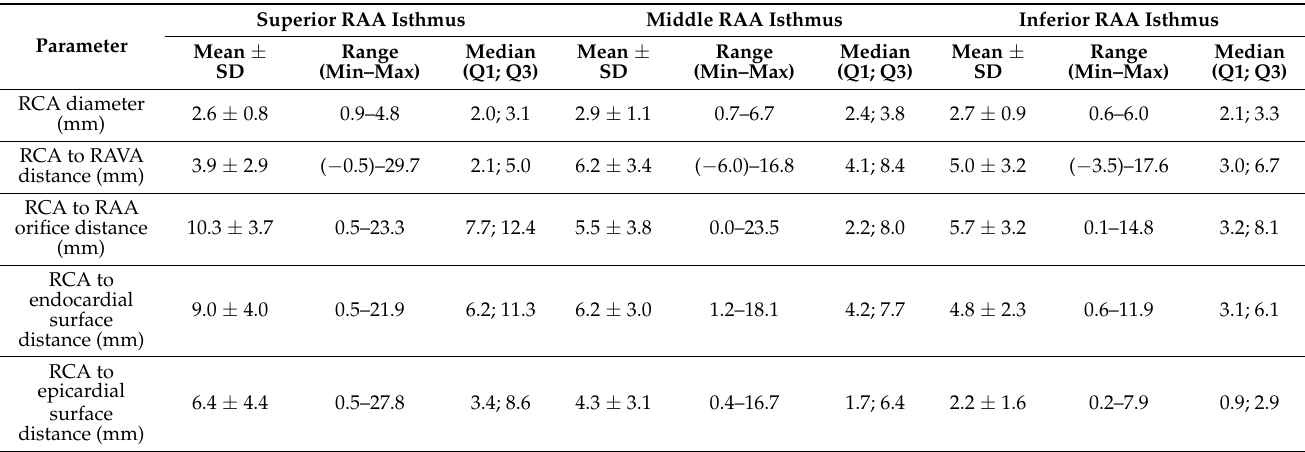
Table 1. Dimensions of the right coronary artery (RCA) identified within the right atrial appendage (RAA) isthmuses and its relations to the endocardial surface, right atrioventricular valve annulus (RAVA), and RAA orifice.